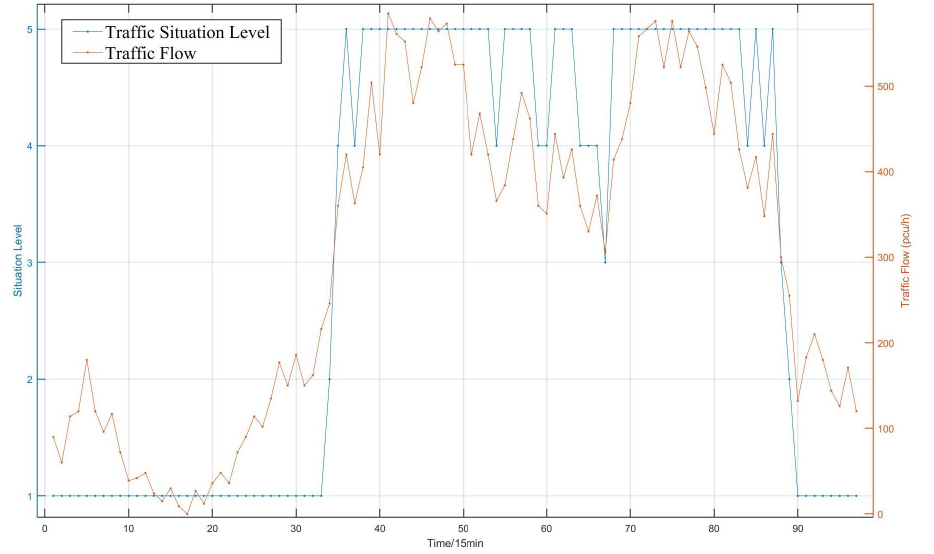
Figure 6. Comparison of the road traffic flow and situation awareness